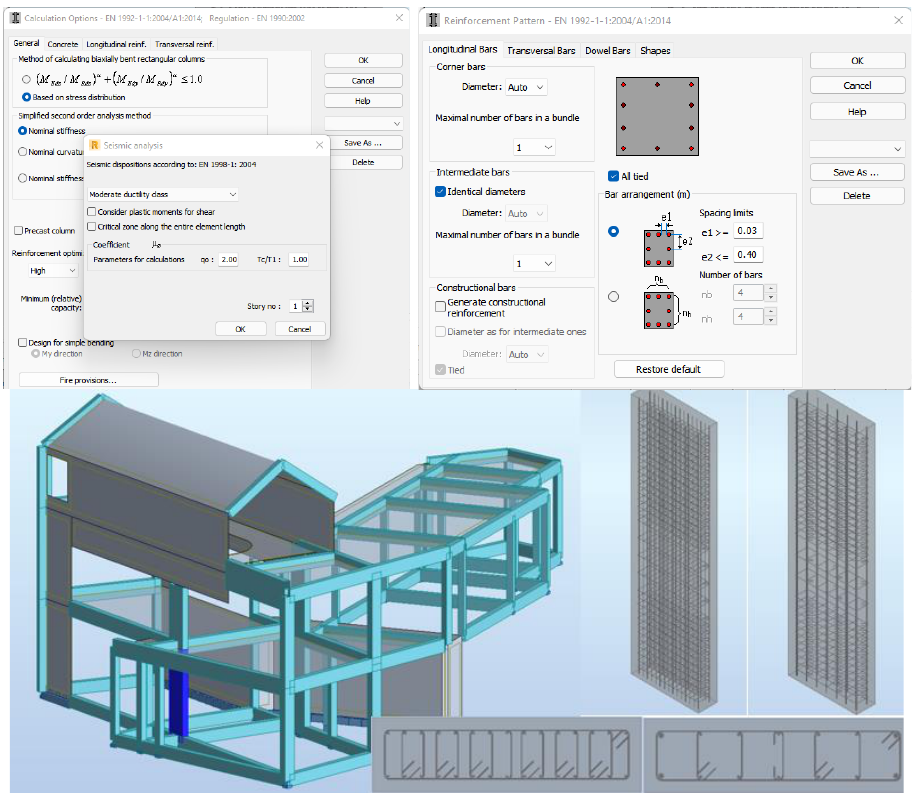
Figure 12. Detailing selected options for the reinforcement of columns.